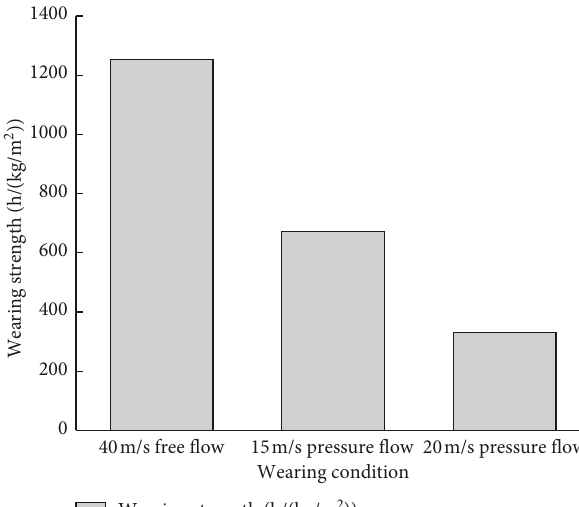
Figure 13: Abrasion-resistance performance of elastic epoxy coating under different